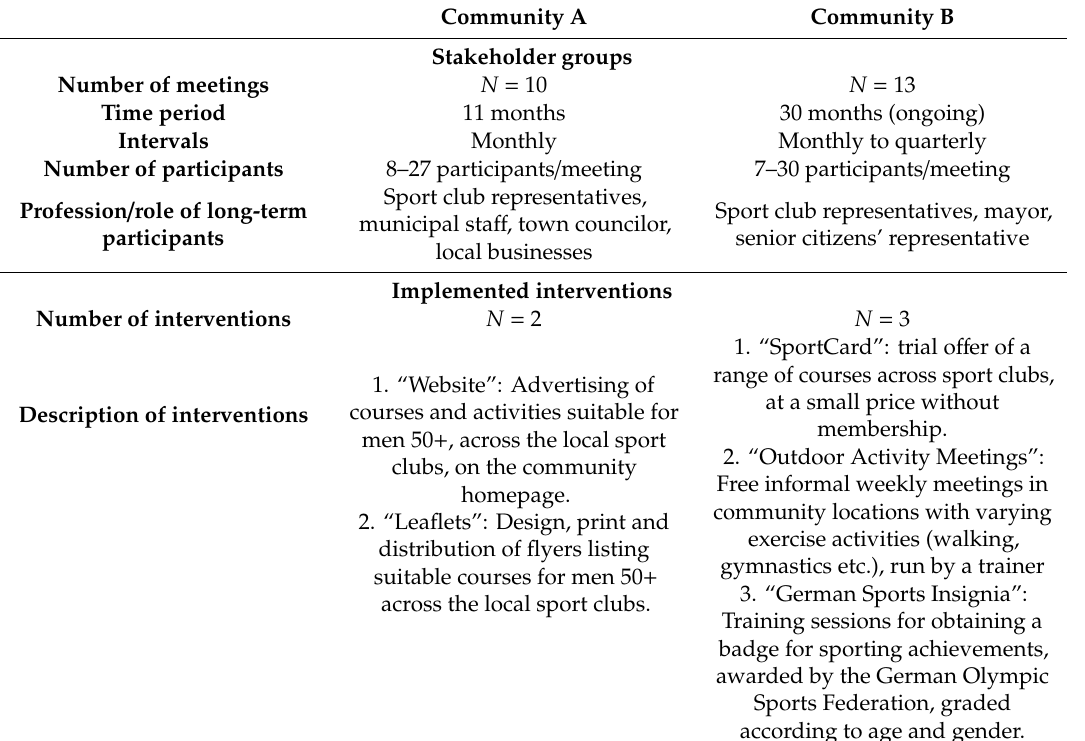
Table 3. Stakeholder group meetings and